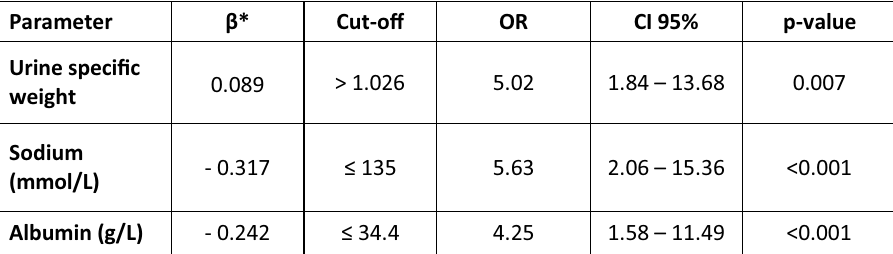
Figure 2. Cut-off values and ROC curve of urine specific weight, sodium and albumin in serum for COVID-19 critically